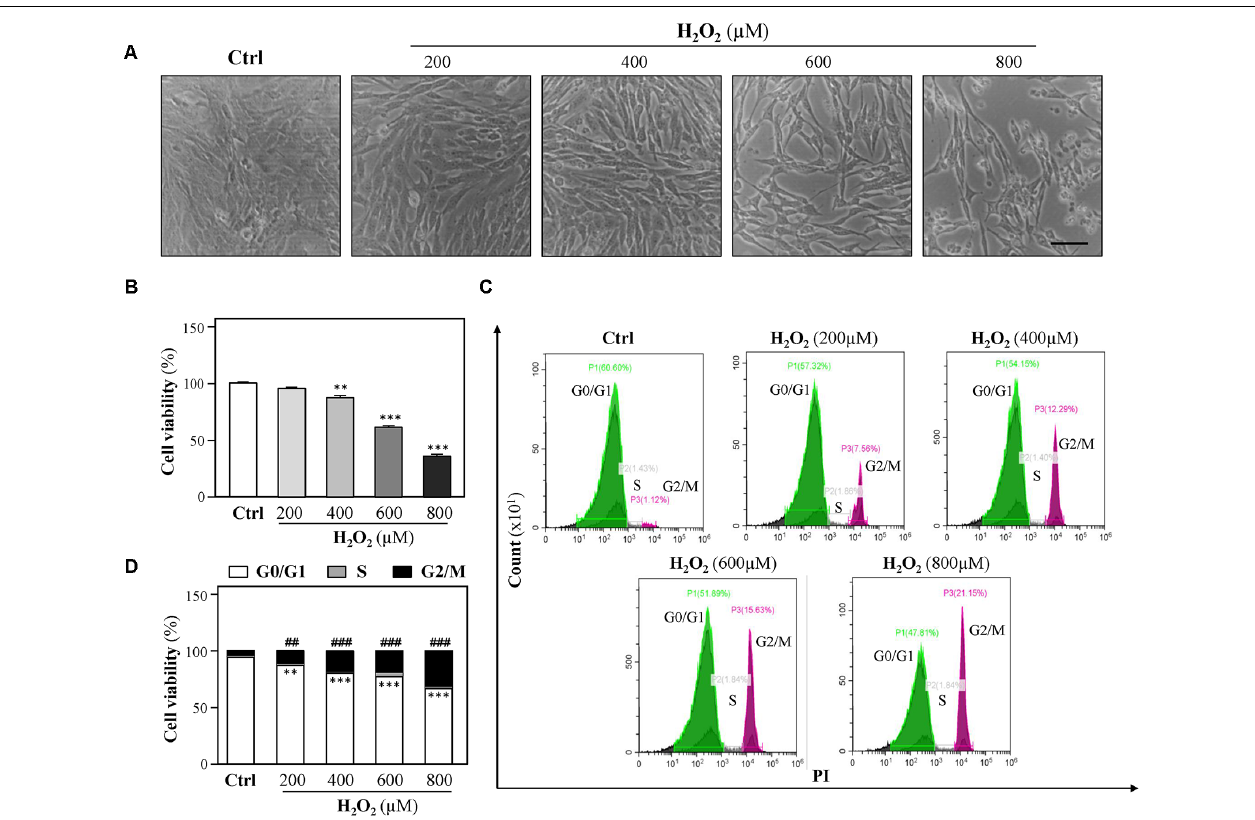
FIGURE 1 | H 2 O 2 inhibits HT-22 cell proliferation. Cultured HT-22 cells were incubated with H 2 O 2 at different concentrations (200–800 µ M) for 24 h; the control group (Ctrl) consists of the untreated cells. (A) Representative images of the cell morphology. Bar = 100 µ m. (B) Cell viability test was performed using CCK-8 kit. (C) The cell cycle was detected by a flow cytometer. (D) Cell viability was calculated as G2/M phase. Values are shown in percentage as compared to control cells. All data in bar charts represent mean ± SEM, n = 3. ∗∗ p < 0.01, ∗∗∗ p < 0.001 represents G0/G1 phase vs. control group; ## p < 0.01 and ### p < 0.001 represents G2/M phase vs. control